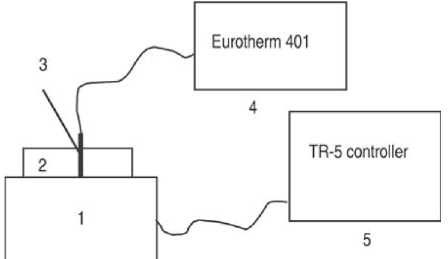
Fig. 3. The principal scheme of the one-side heating